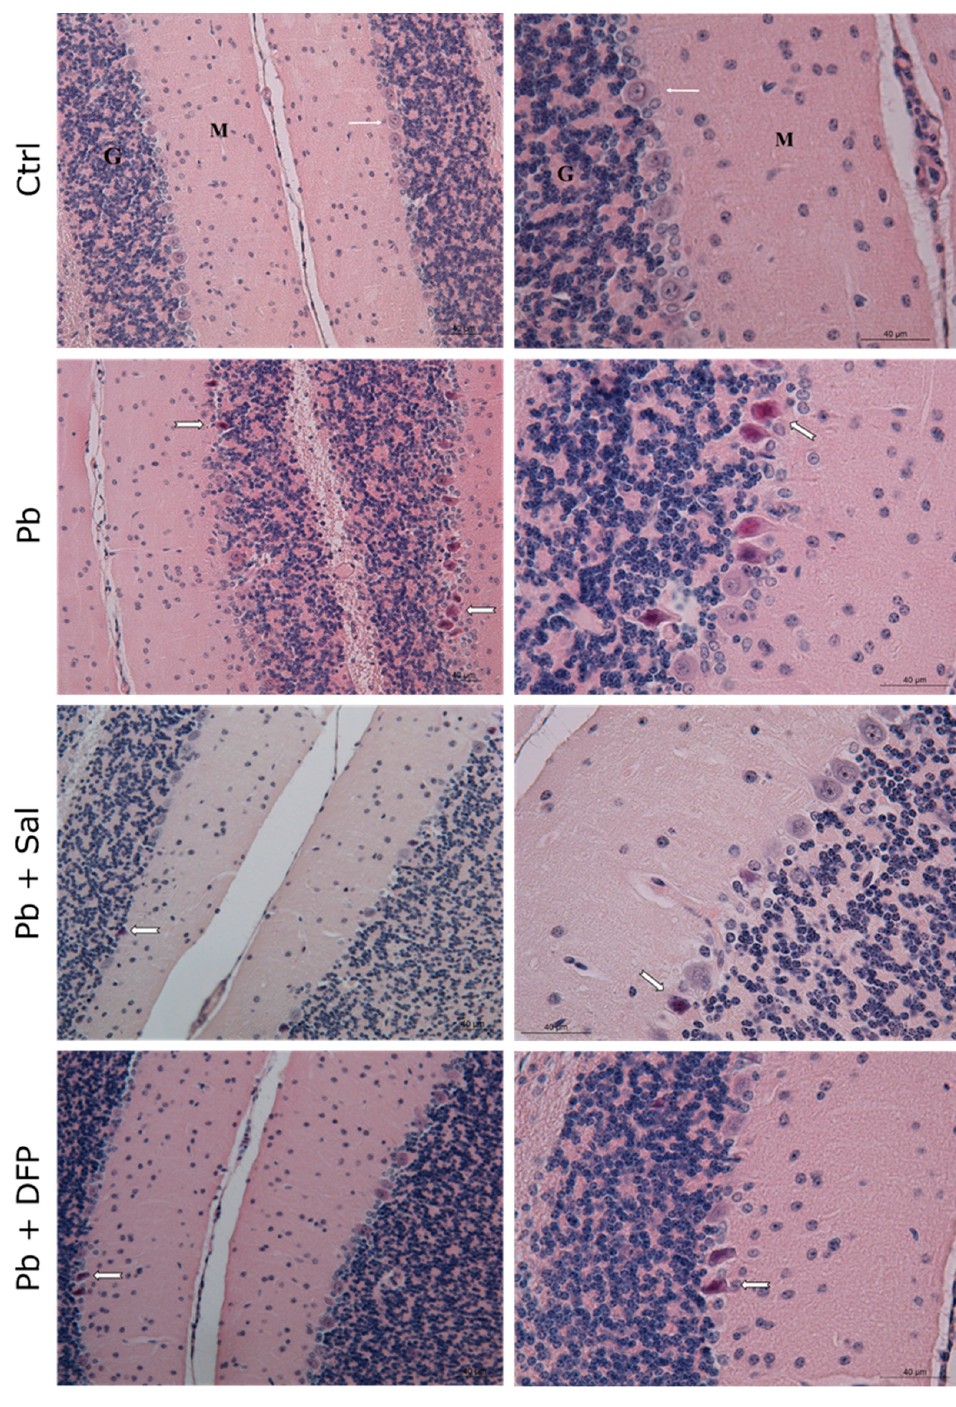
Figure 4. Light microphotographs of the cerebellar cortex of experimental mice. Ctrl—untreated control mice. Different layers of the cortex: molecular layer (M), Purkinje cell layer (white, thin arrow), and granular layer (G). Pb—Pb-exposed mice. Many pyknotic Purkinje cells (white, thick arrow). Pb + Sal—Pb-exposed mice, subjected to treatment with salinomycin. A few pyknotic Purkinje cells (white, thick arrow). Pb + DFP—Pb-exposed mice, treated with deferiprone. A few pyknotic Purkinje cells (white, thick arrow). Hematoxylin-eosin staining, × 200; × 400. Pb intoxication resulted in brain pathological changes with features of neuronal necro- sis. Numerous shrunken, darkly stained pyknotic neurons and dilated perivascular spaces were demonstrated in the cerebral cortex. Many damaged, shrunken Purkinje cells